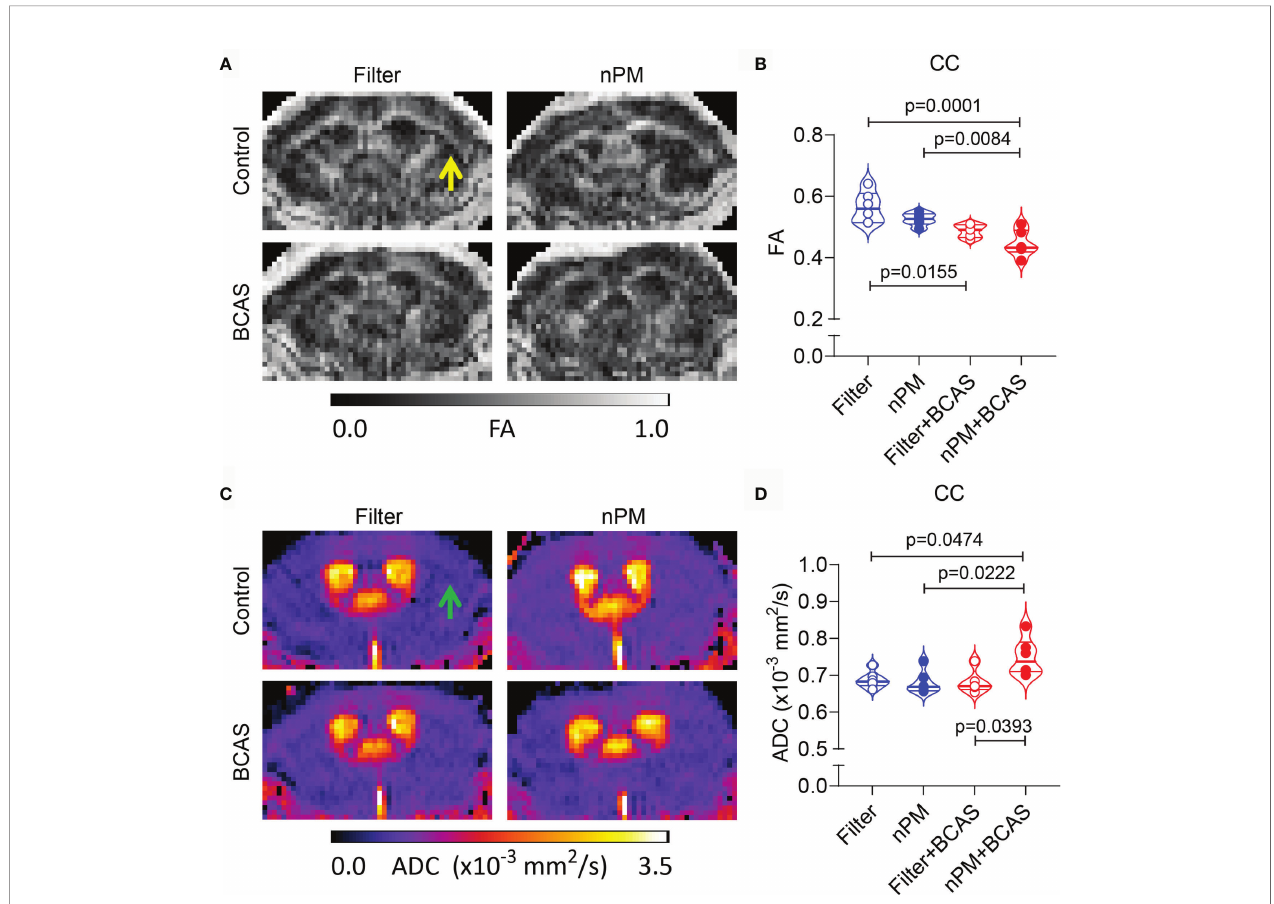
FIGURE 4 | Altered diffusion metrics in white matter of nPM exposed BCAS mice. (A, B) Diffusion weighted MRI was used to measure integrity of white matter in mice and FA maps were generated (A) and quanti fi ed within the corpus callosum area (B) . (C, D) ADC maps were generated using diffusion weighted MRI (C) and values (x10 -3 mm 2 /s) were quanti fi ed in the corpus callosum area (D) . Notice lack of white and gray matter contrast especially in nPM+BCAS group in the corpus callosum area [arrows in (A, C) ]. In panels (B, D) n = 6 in fi lter, nPM and nPM+BCAS groups and n = 5 in fi lter+BCAS group. Data is presented as violin plot with median and quartiles. 1-way ANOVA and Bonferroni Post Hoc tests were used for statistical testing. CC, corpus callosum; FA, fractional anisotropy; ADC, apparent diffusion coef fi